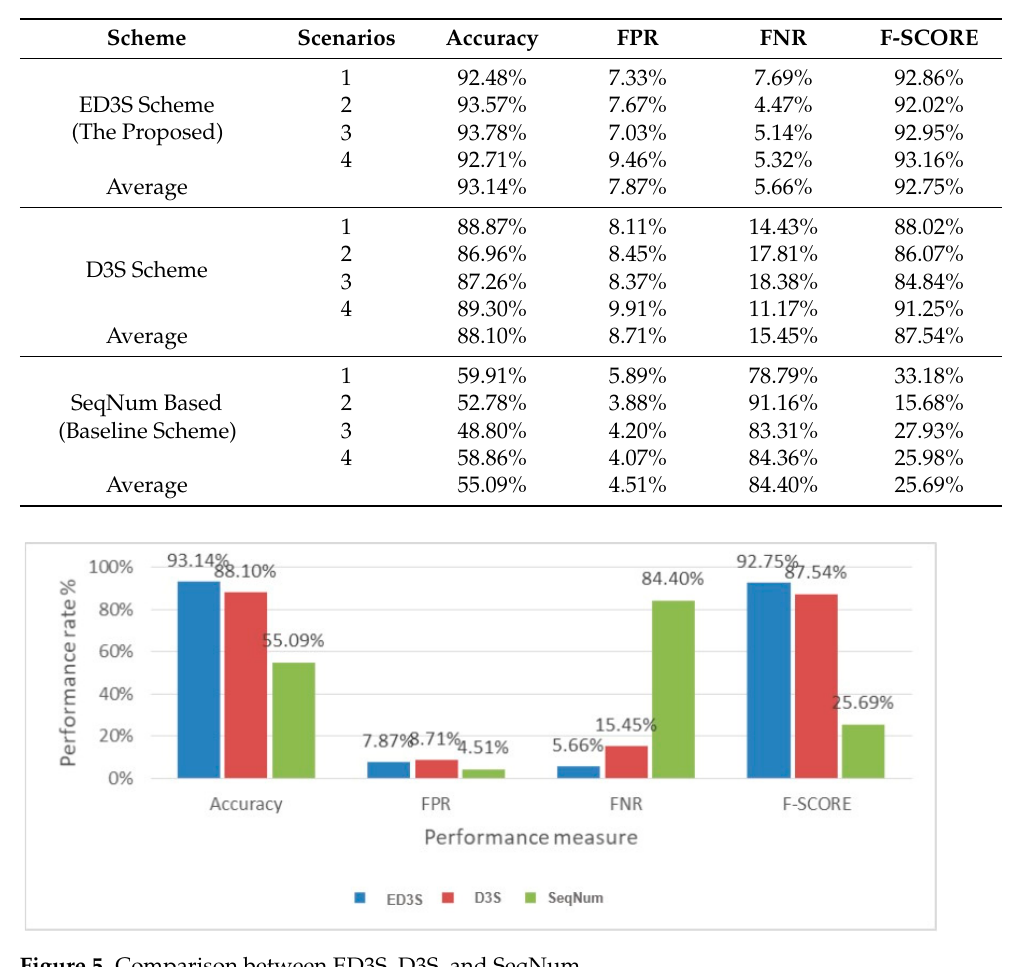
Table 1. The Results of the ED3S Scheme, D3S Scheme, and SeqNum Based on Four Scenarios.